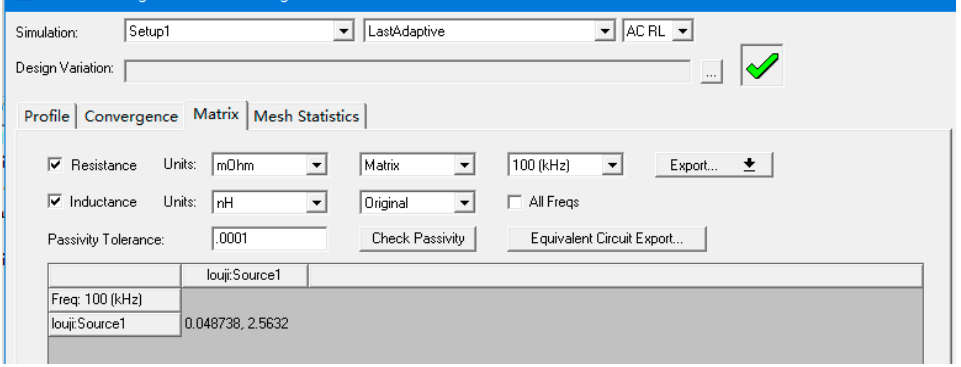
Figure 7. Simulation results of grid parasitic inductance and resistance matrix. Table 1. Parasitic inductance, resistance, and capacitance values of the MOSFET poles to ground.